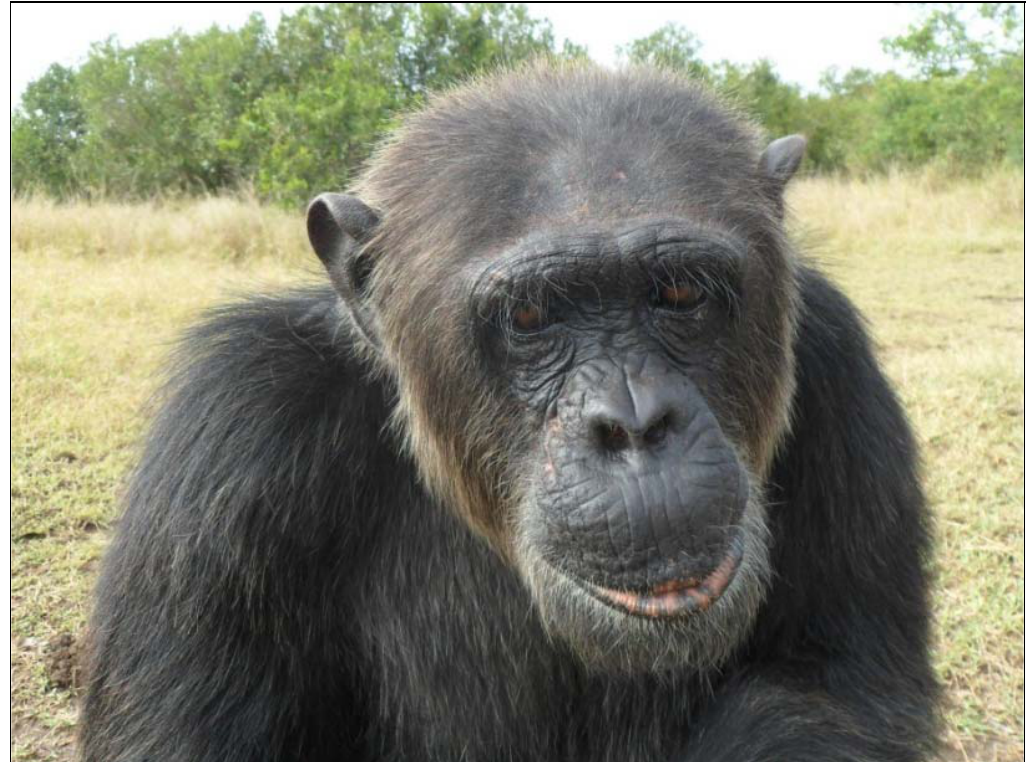
Figure 3. Safari at Sweetwaters Chimpanzee Sanctuary in